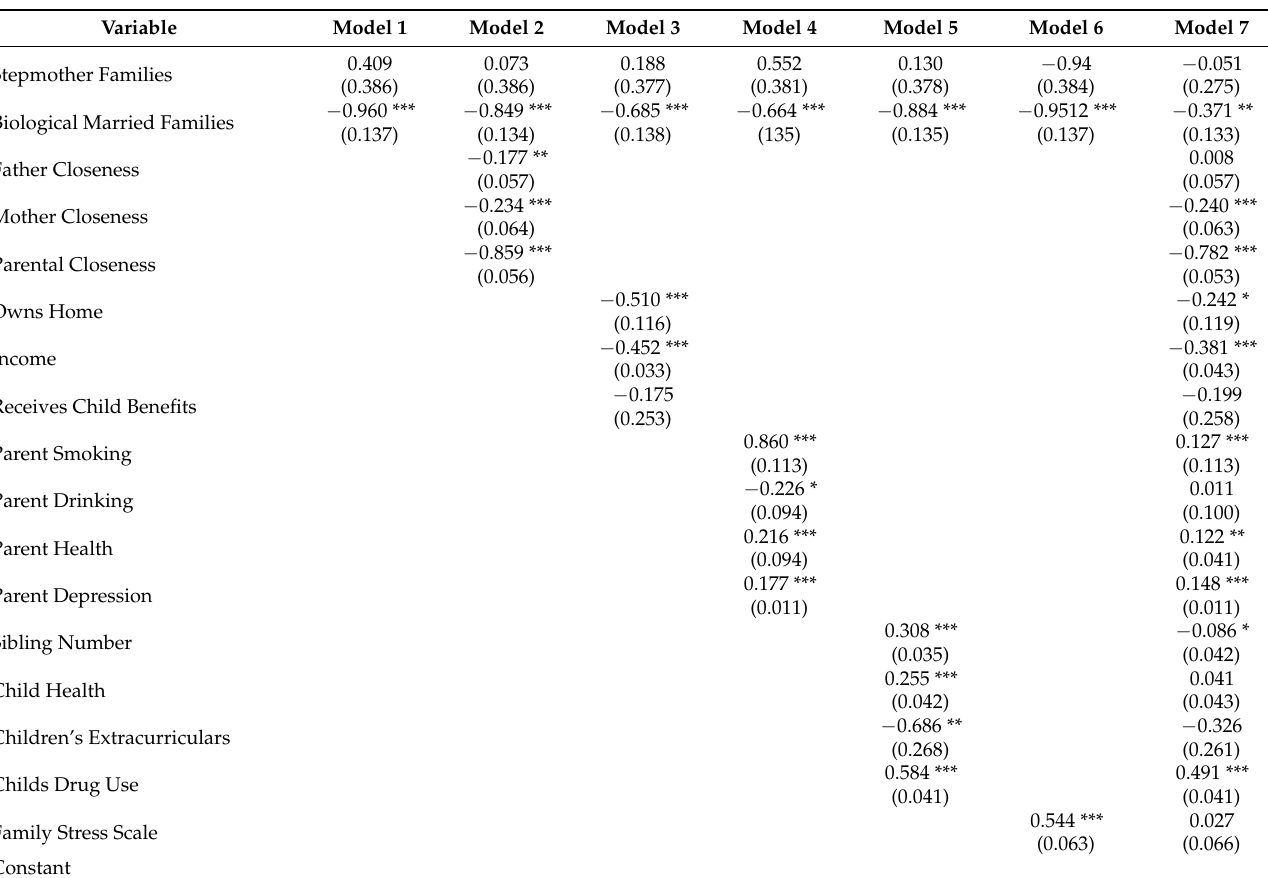
Table 6. Ordinary Least Squares Regression of Externalizing Behavior Problems on Family Structure (Model 1), Parental Closeness (Model 2), Financial Resources (Model 3), Parental Health (Model 4), Child Health (Model 5), Family Stress (Model 6) and Full Model (Model 7). Cohabiting families with both biological parents are the reference